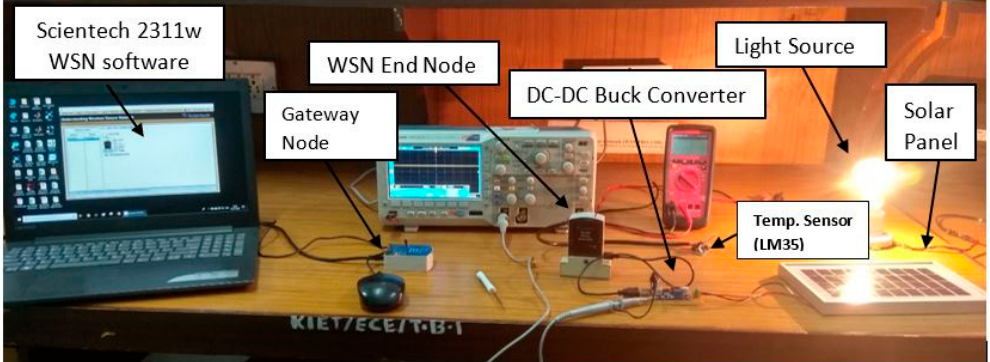
Figure 14. Hardware Experiment setup of SEH-WSN system.